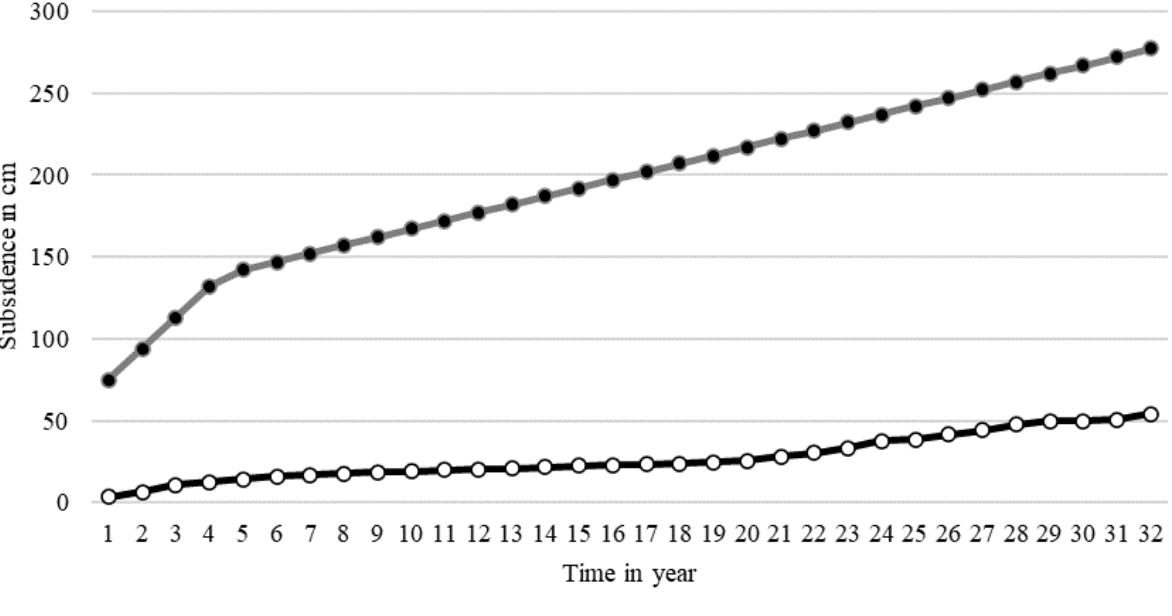
Figure 5. Comparison of accumulated subsidence between drained peatland under agriculture from Hooijer et al. (2012), and the Pulau Burung coconut plantation